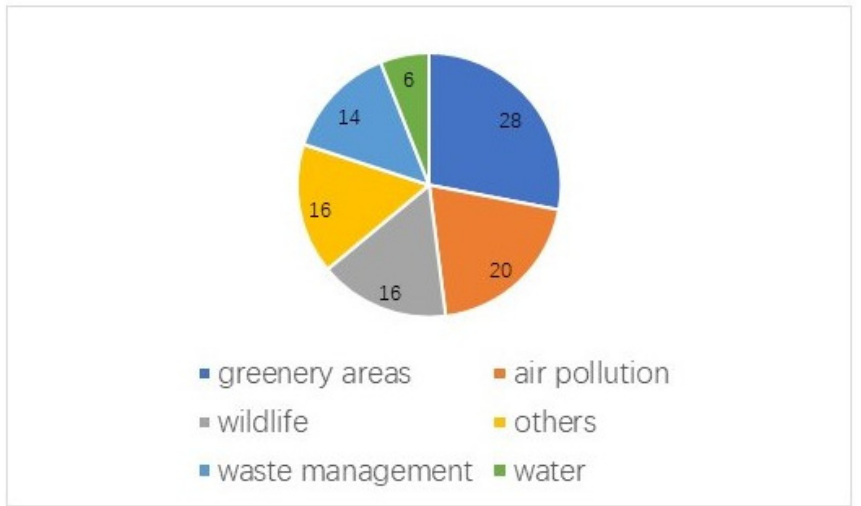
Figure 1. The share (%) of environmental news covering Tehran in two newspapers.